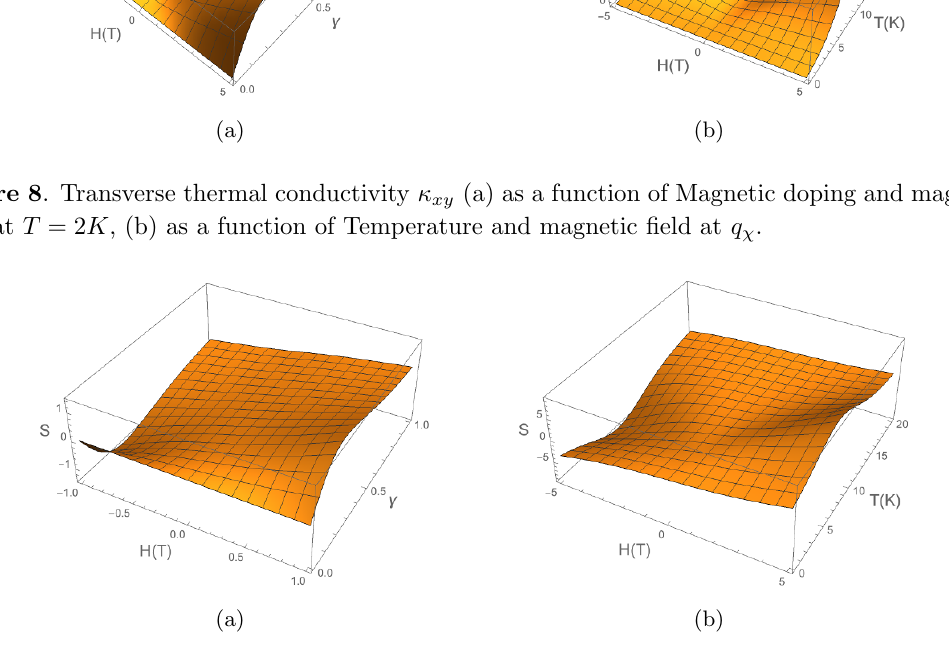
Figure 9 . Seebeck coe(cid:14)cient S (a) as a function of Magnetic doping and magnetic (cid:12)eld at T = 2 K , (b) as a function of Temperature and magnetic (cid:12)eld at q (cid:31) (cid:13) = 0 :